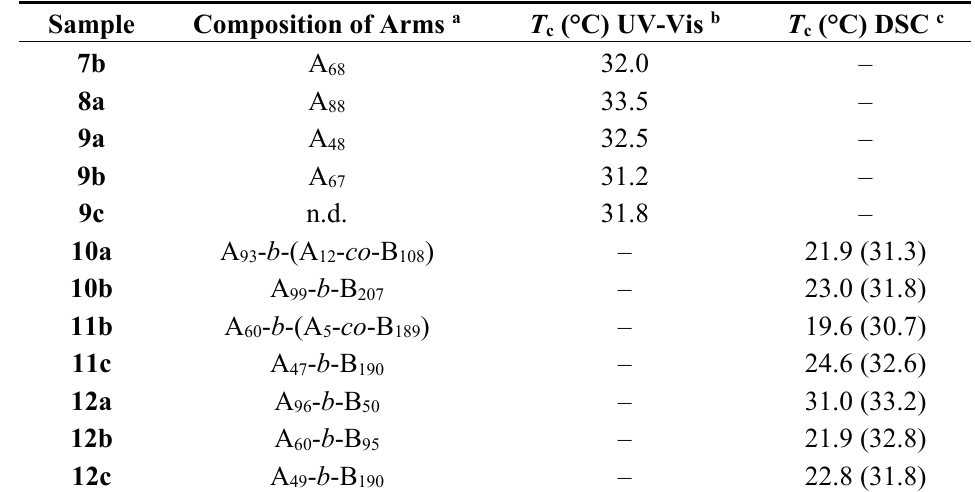
Table 4. Critical phase transition temperatures T c of the star-like PNIPAAm homo polymers in aqueous